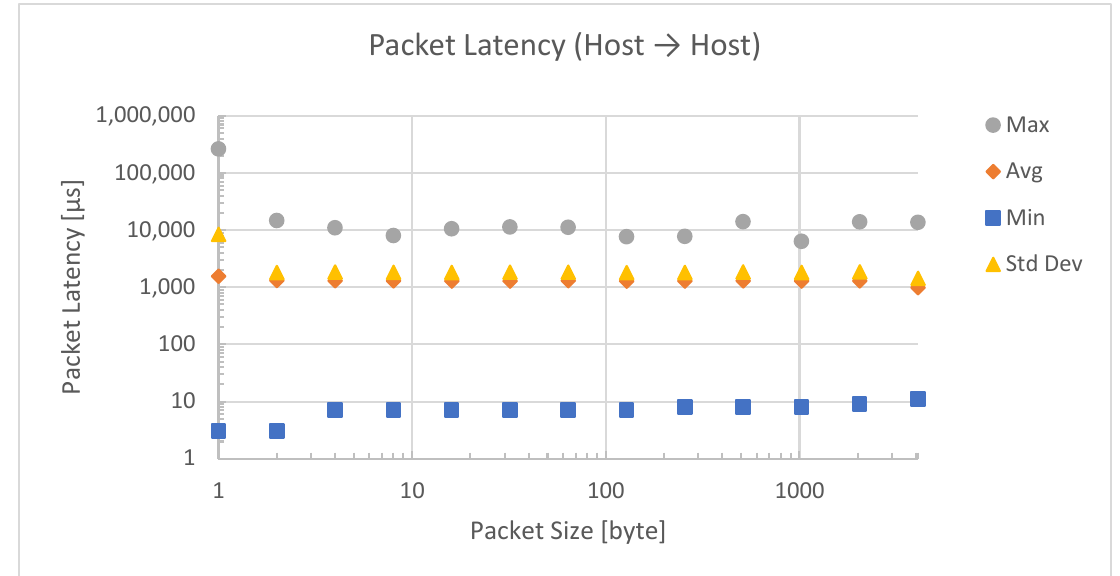
Figure 8. Packet latency for a direct host-to-host connection. The same effect can be observed in the latency measurements for data transmission over the wireless bridge. Dedicated measurements were taken for both directions of the bridge, which are shown in Figures 9 and 10.